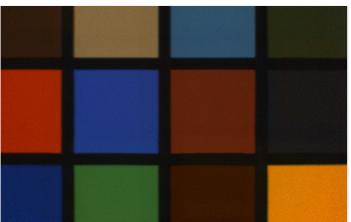
Figure 3. A part of X-rite ColorChecker board composed from wavebands: 489, 534, and 618 nm